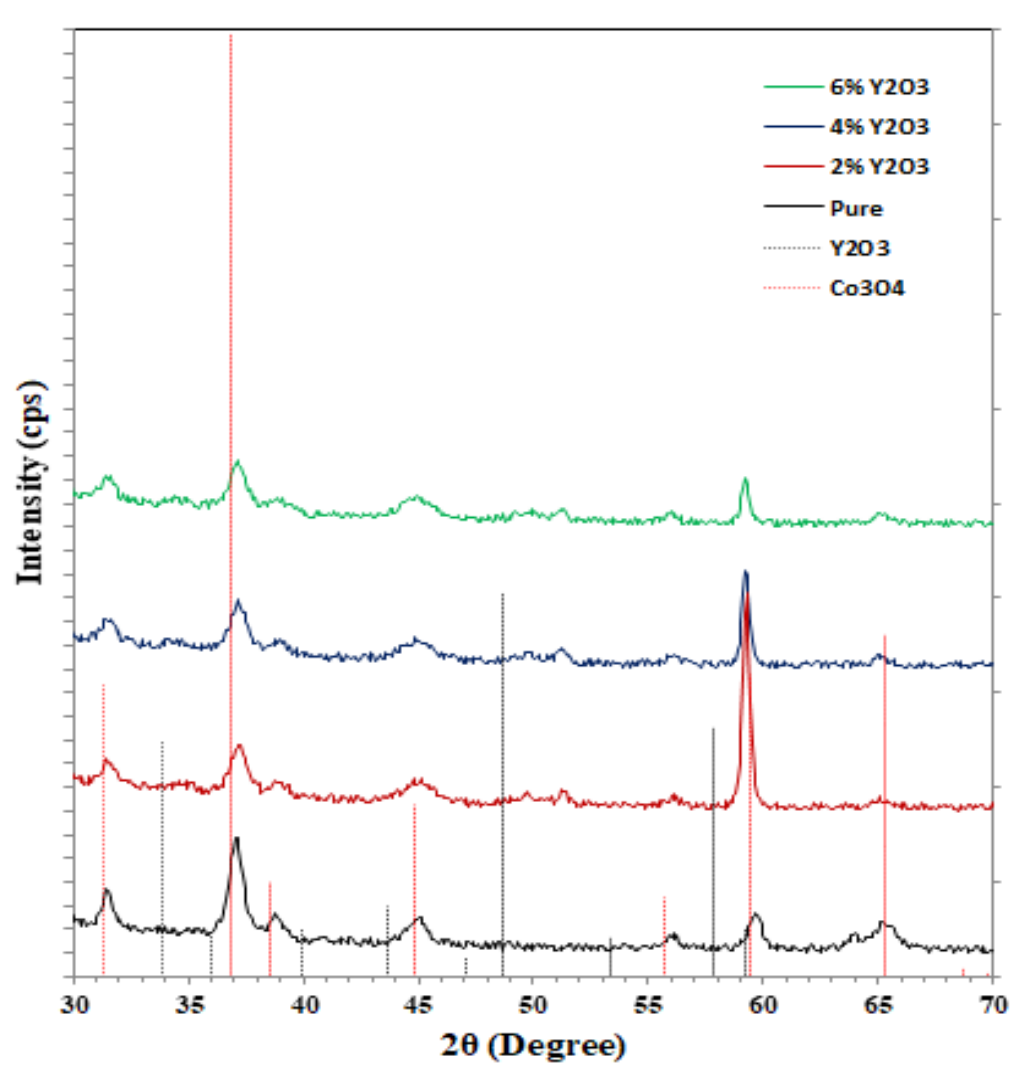
Figure 1: XRD patterns for undoped Co yttria thin films deposited on n-Si substrate by hydrothermal